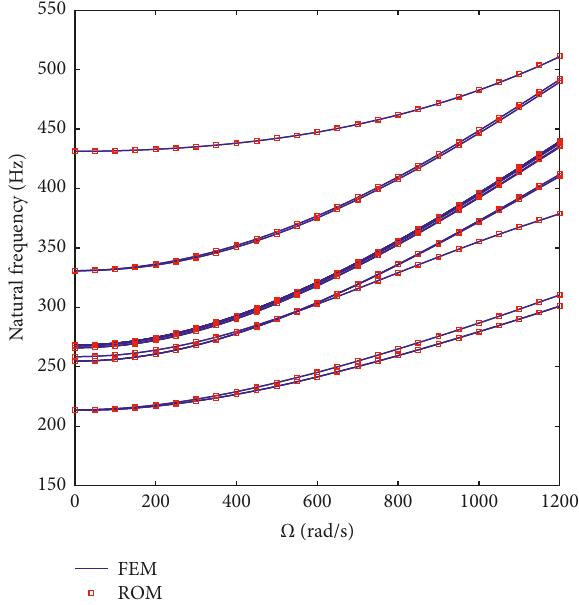
Figure 3: Evolution of first eight natural frequencies versus ro- tating speed of the full-order model and reduced-order model considering the Coriolis forces, spin softening, and stress stiffening effects. Table 1: Mistuning parameters of bladed